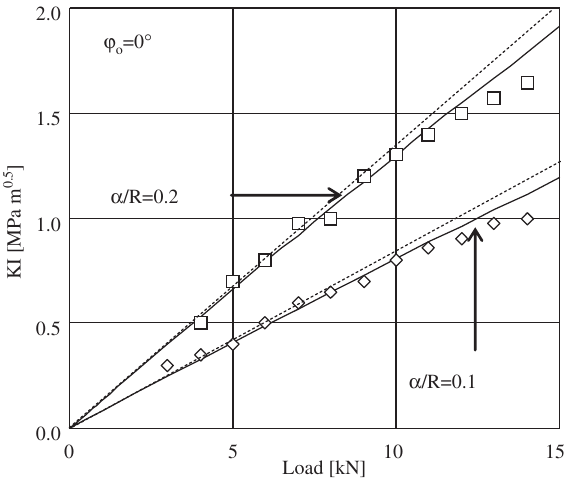
Figure 10 The mode I SIF for a disc made of PMMA with f deviation from linearity (dotted lines) is clear for both crack lengths considered. The square and rhomboid symbols correspond to the values experimentally obtained with the aid of the reflected caustics